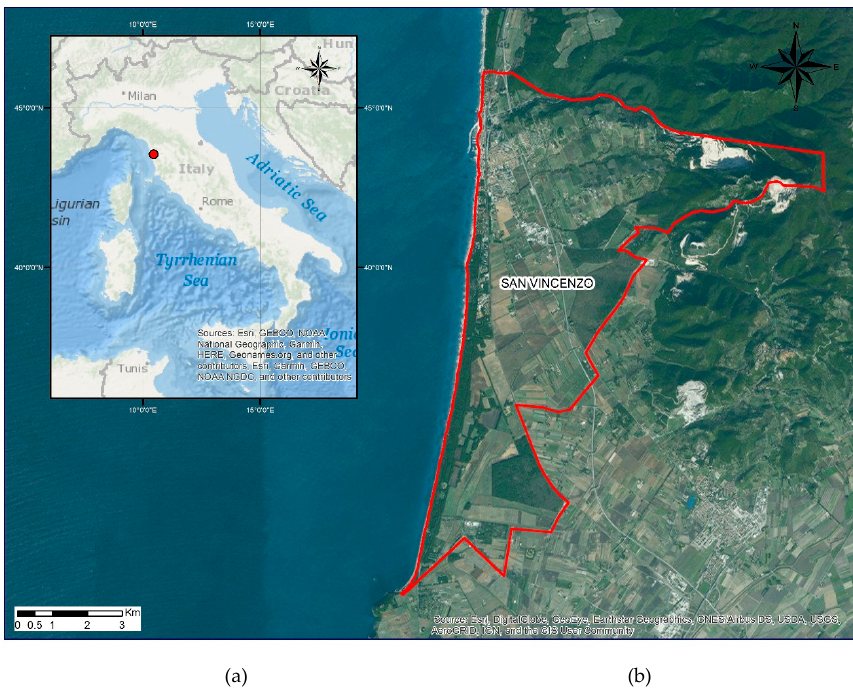
Figure 1. (a) Location of San Vicenzo in the Mediterranean area (red circle marks the study site); (b) Map of San Vincenzo municipality (in red) on the northwestern coast of Italy.